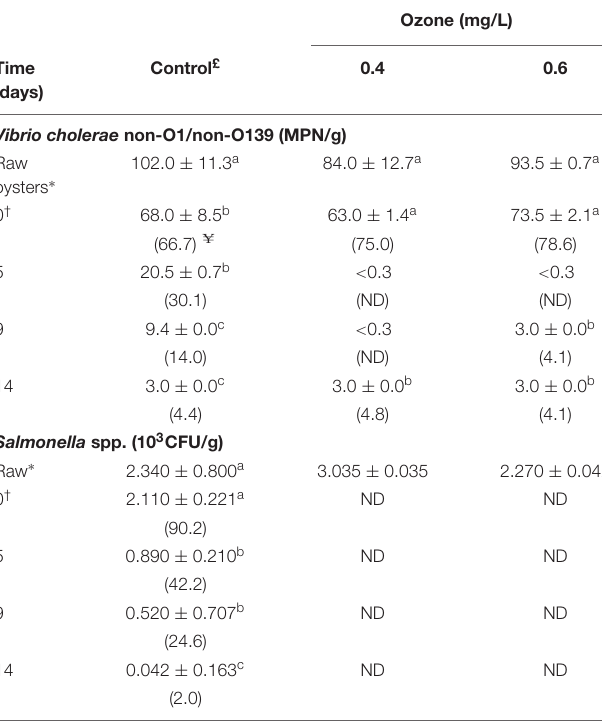
TABLE 4 | Survival of Vibrio cholerae and Salmonella spp. in ozonated American oyster ( Crassostrea virginica ) superchilled stored at − 1 ◦